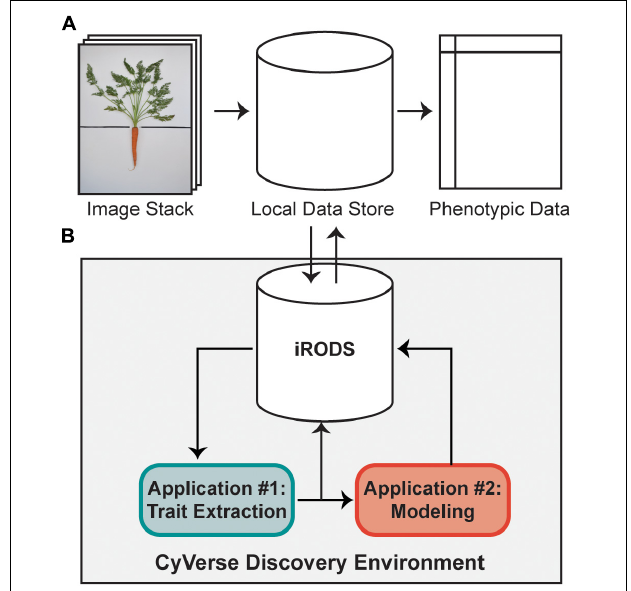
FIGURE 1 | A high-throughput workflow to measure carrot morphology from images. (A) A user collects a stack of individual carrot images, which are uploaded from a local data store to the iRODS data system on CyVerse for trait extraction. Following image processing, quantitative data is returned to the user for downstream analyses. (B) Once uploaded to CyVerse, images are processed in the Discovery Environment using custom algorithms via a high-throughput computing (HTC) resource. The workflow is split into two applications: the first extracts traits which are directly measured from the image (e.g., area, bounding box, etc.), while the second uses a regression model built from a validation set of 100 ground-truth measurements to predict petiole number, petiole length, and petiole